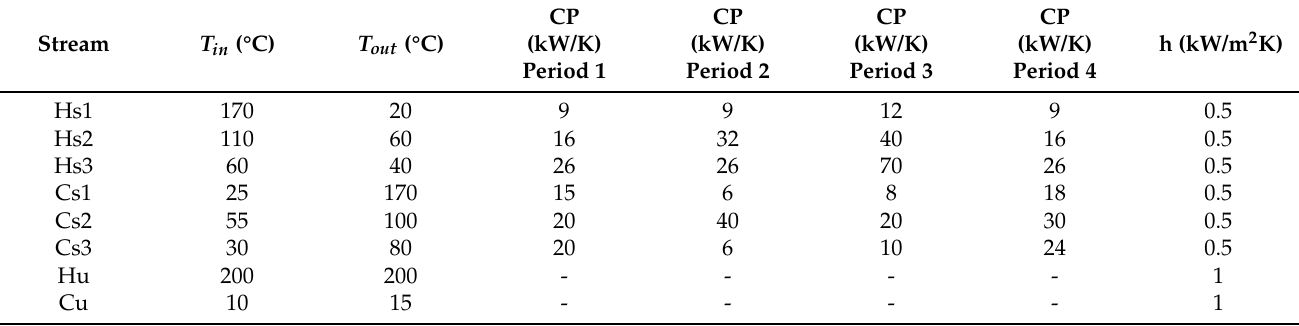
Table 2. Stream data for case